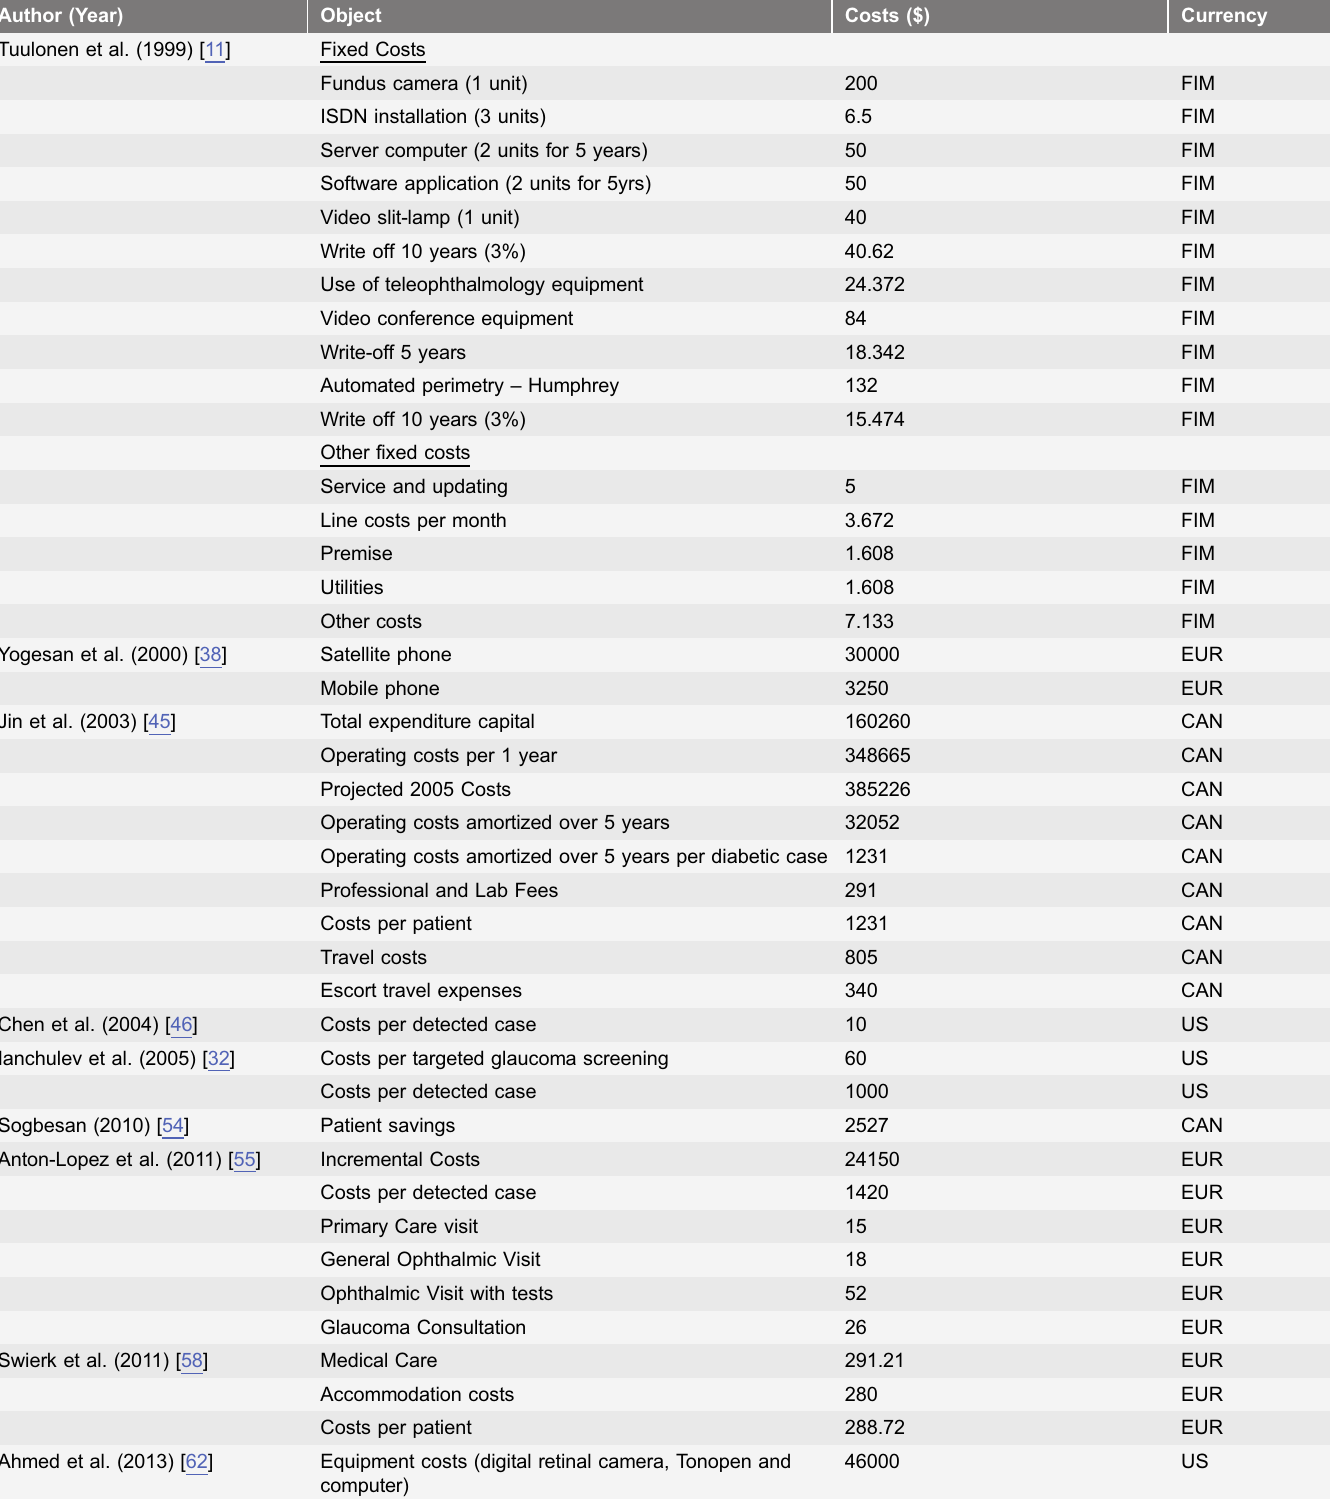
Table 6. Quality of analysis for